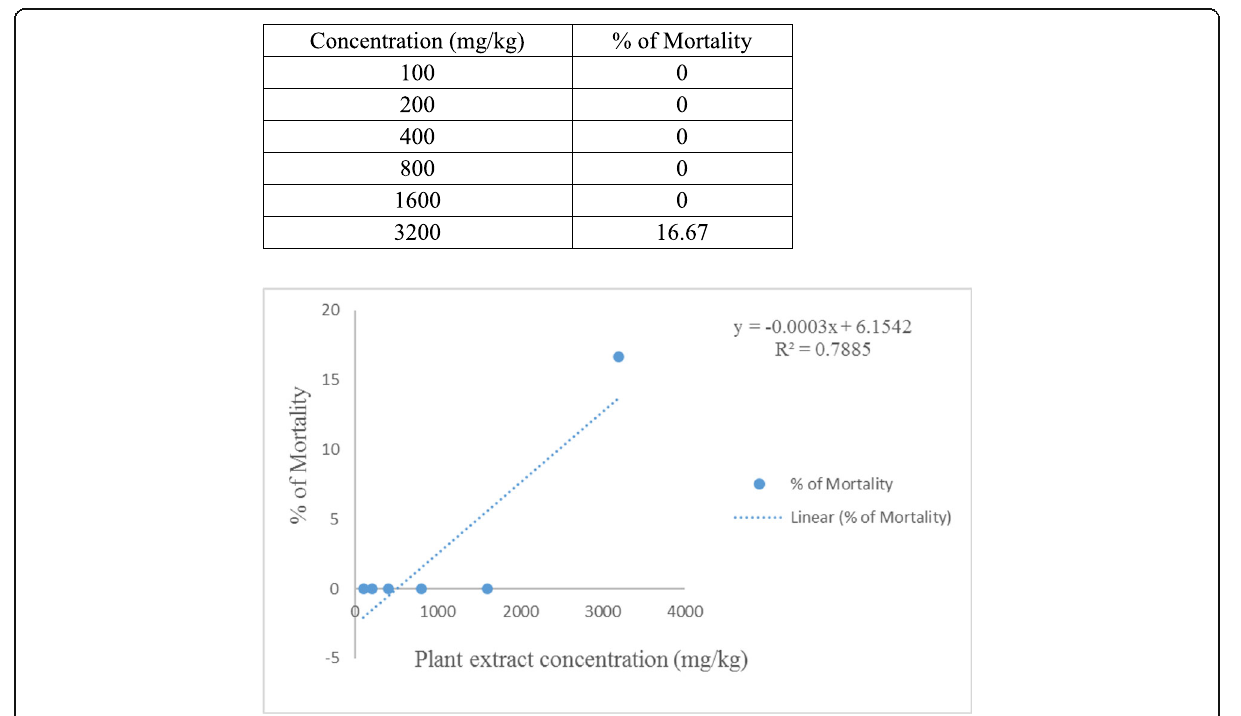
Fig. 1 LD 50 value of Chenopodium album leaf extract on Swiss albino